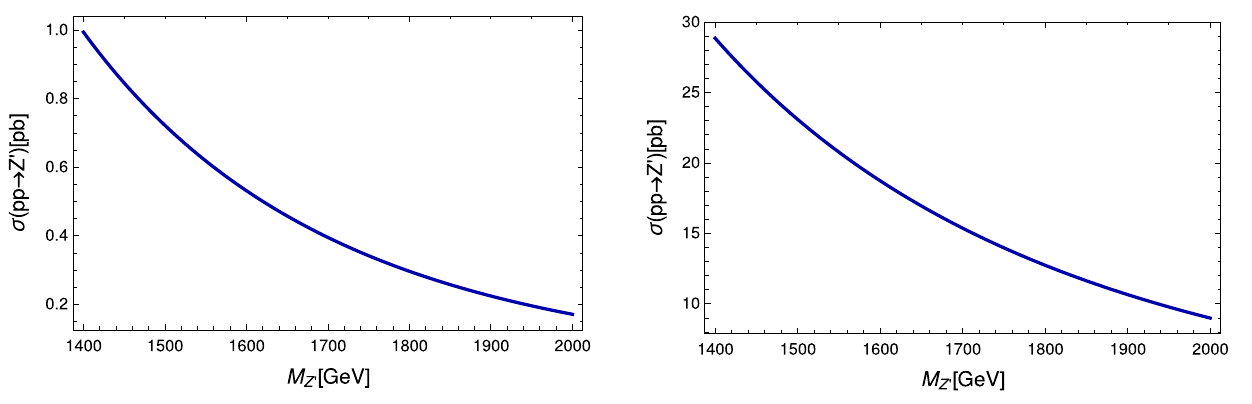
Fig. 2 The total Z (cid:2) production cross section via the DY mechanism at √ S = 13 TeV and g X = 0 . 1 as a function of the Z (cid:2) mass the LHC for g 2 π σ DY ( S ) = pp → Z (cid:2) 6 c 2